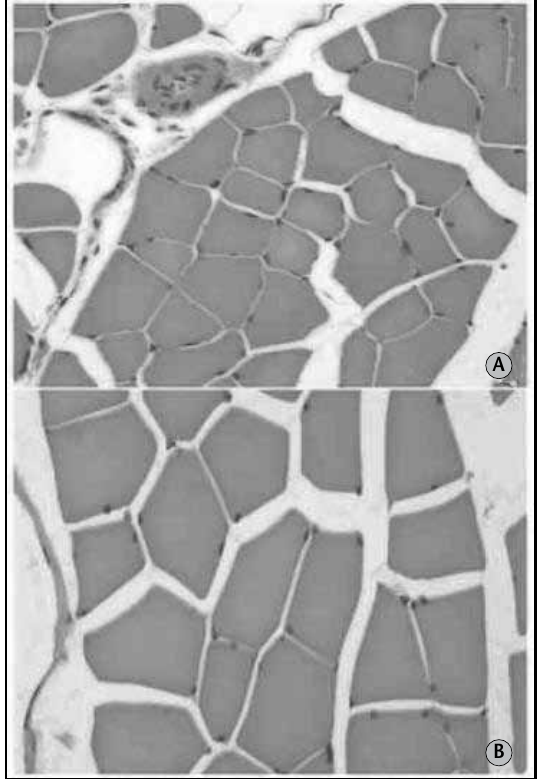
Figura 4 – Tecido muscular esquelético (A) grupo tibolona: fibras de formato poliédrico, ligeiramente arredondado, com diâmetro médio variando entre 28,2 μm e 38,9 μm; (B) grupo-controle: fibras mais volumosas, algumas discretamente angulosas, com diâmetro médio variando entre 35,3 μm e 38,6 μm. HE, aumento original 400×. HE: hematoxilina e eosina.